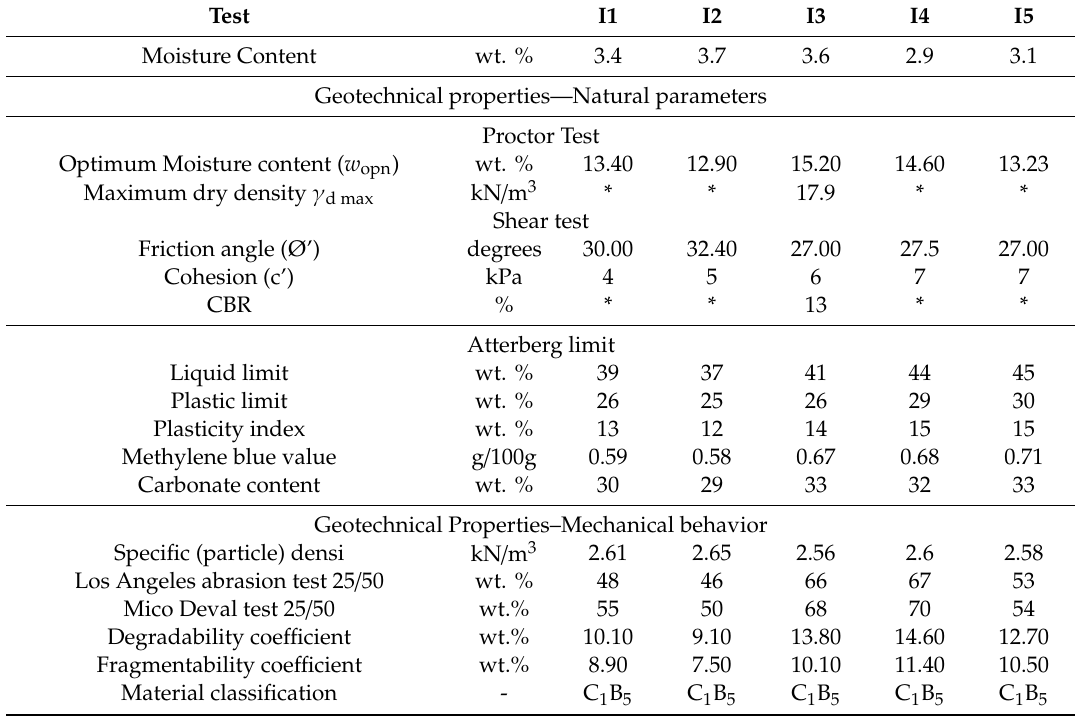
Table 1. Physical and geotechnical properties of collected